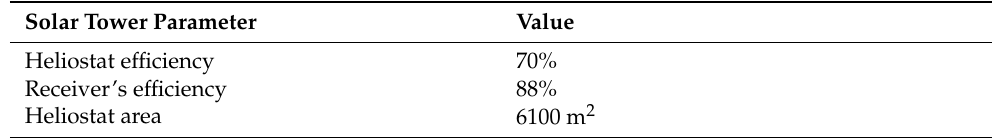
Table 1. Important parameters used to model the solar